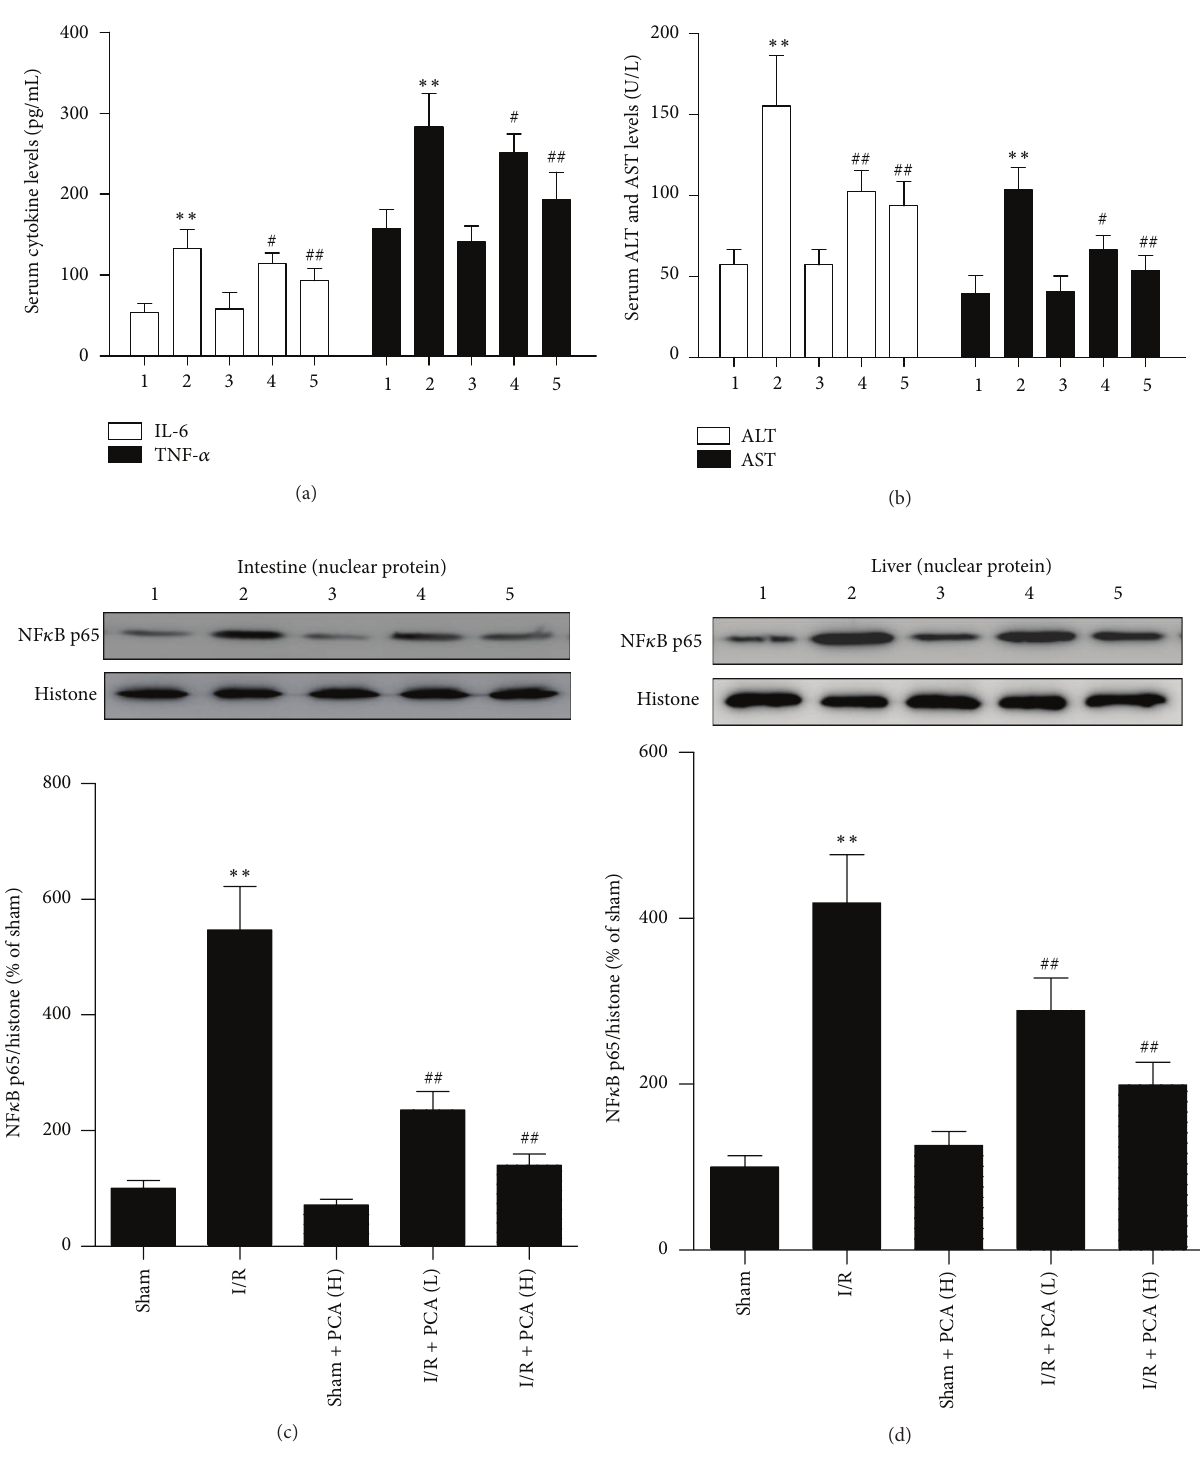
Figure 3: PCA pretreatment ameliorated intestinal I/R-induced systemic inflammation, hepatic dysfunction, and NF 𝜅 B activation. ((a) and (b)) Alterations of IL-6, TNF- 𝛼 , ALT, and AST in the serum, 𝑛 = 10 . (c) Western blot analysis of nuclear NF 𝜅 B p65 in the intestine, 𝑛 = 3 . (d) Western blot analysis of nuclear NF 𝜅 B p65 in the liver, 𝑛 = 3 . Results are presented as the mean ± SD. ∗∗ 𝑃 < 0.01 versus sham group; # 𝑃 < 0.05 versus I/R group; ## 𝑃 < 0.01 versus I/R group. 1 indicates Sham; 2, I/R; 3, Sham + PCA (H); 4, I/R + PCA (L); 5, I/R + PCA